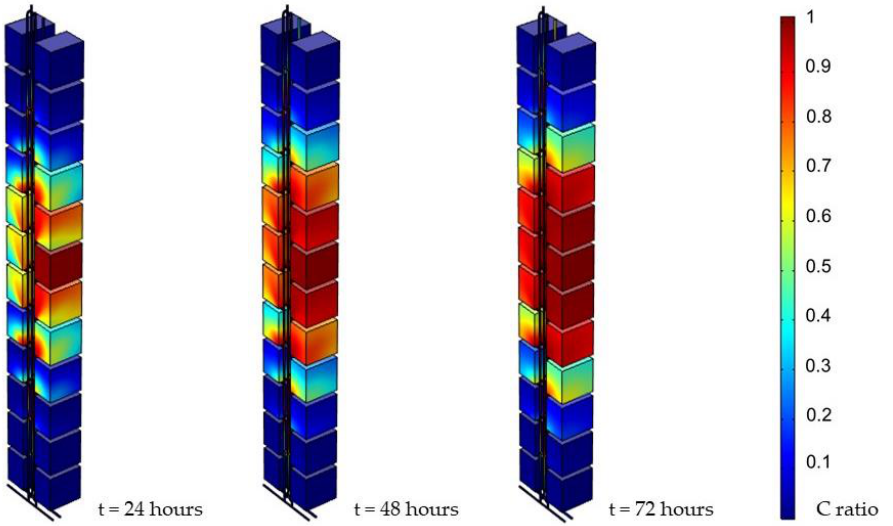
Figure 11. Simulation results of alternative scenario (0.05 Pa, 1000 ppm).